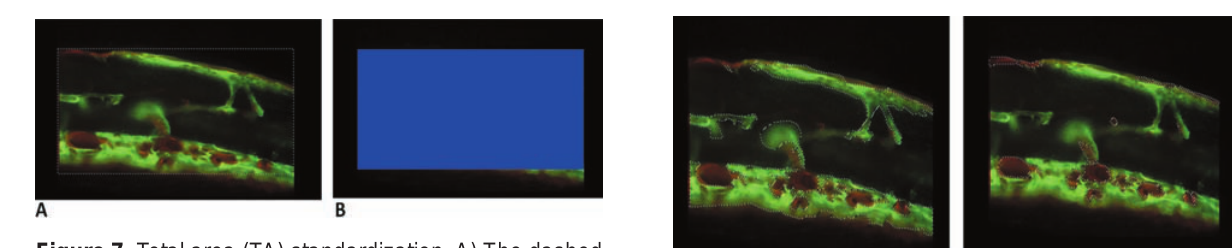
Figure 7- Total area (TA) standardization. A) The dashed lines delimit the area; B) Imagelab 2000® program calculated the area in pixels